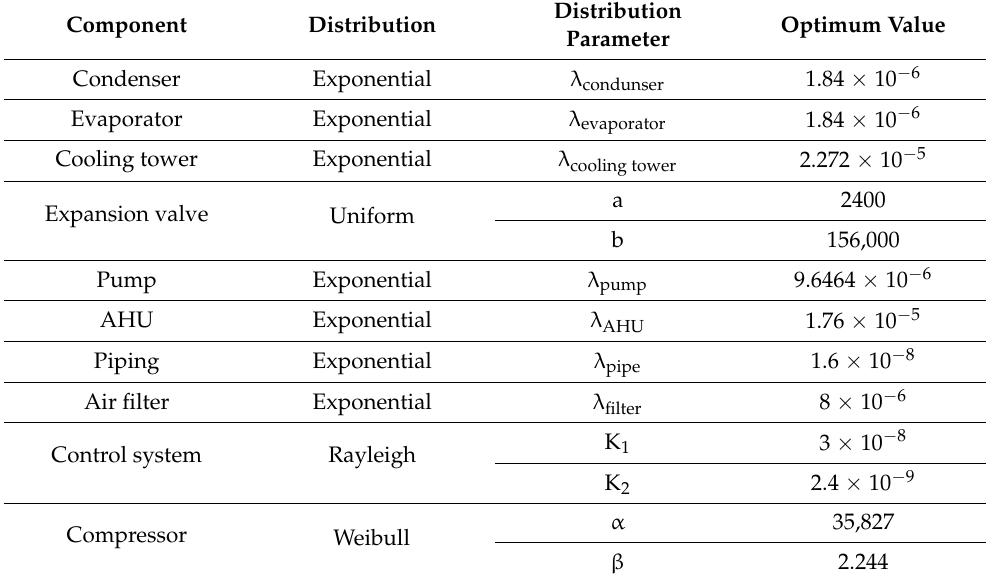
Table 8. The optimized distribution parameters.